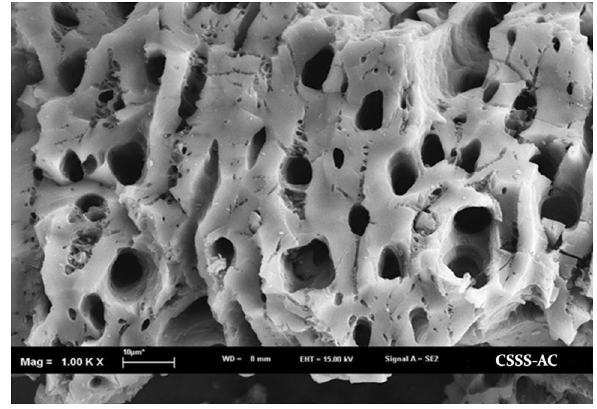
Fig. 6 Scanning electron micrograph (1000×) of the optimal acti-